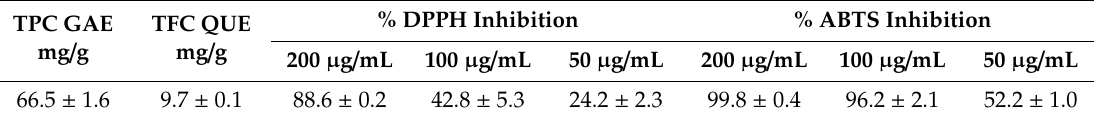
Table 3. Total phenolic content (TPC), total flavonoid content (TFC), DPPH, and ABTS radical inhibition results.